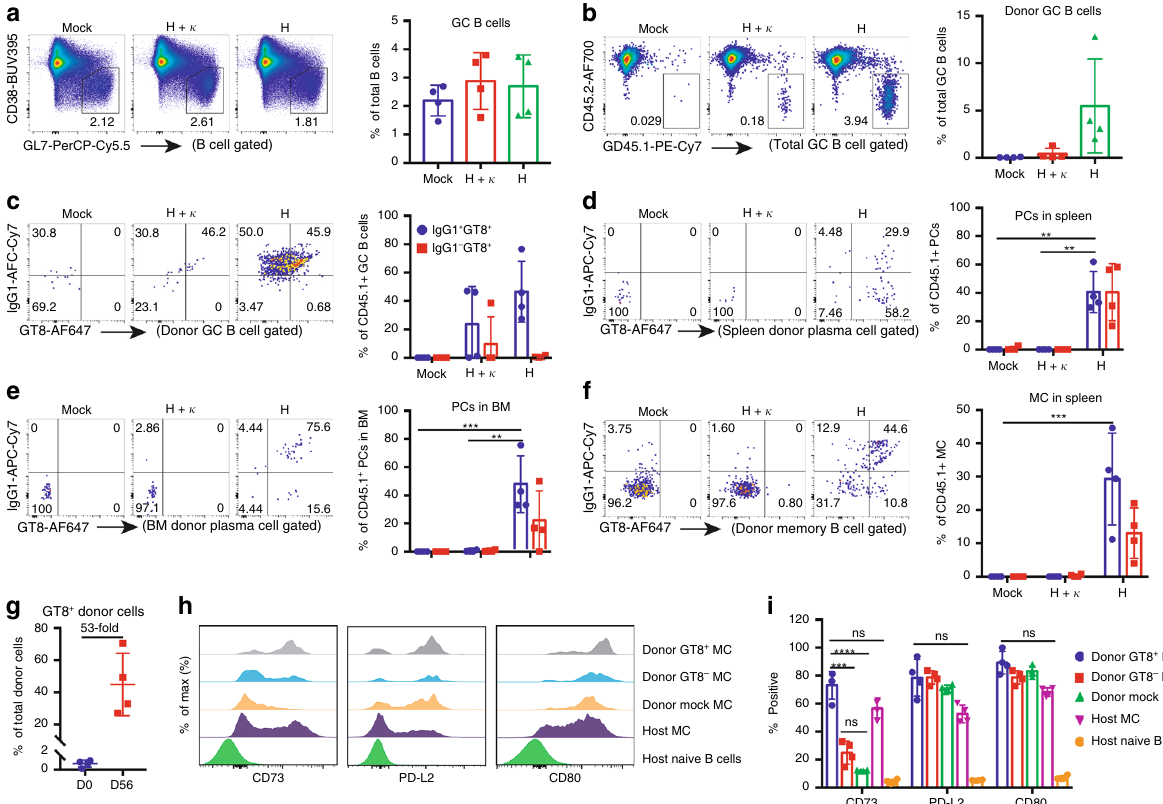
Fig. 3 Flow cytometric analysis of antigen-matured engineered B cells. Host mice receiving LPS activated only (Mock), H + κ , or H - targeted B cells were analyzed 14 d after the fi rst boost (w8). n = 4 mice in each group. a – c , Germinal center (GC) B cells. a Representative fl ow cytometry and statistical analysis of total GC B cells pre-gated as live, CD19 + singlets. b CD45.1 + (donor) GC B cells. c Fraction of cells gated in ( b ) which were class-switched IgG1